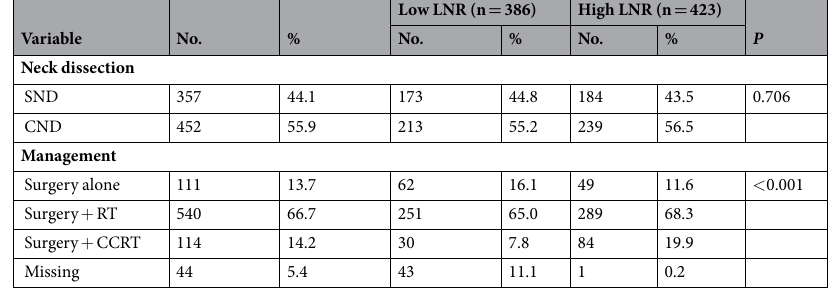
Table 1. Baseline demographics of the 809 patients included in this study. Notes: LNR, lymph node ratio; SD, standard deviation; SND, selective neck dissection; CND, comprehensive neck dissection; RT, radiotherapy; CCRT, concurrent